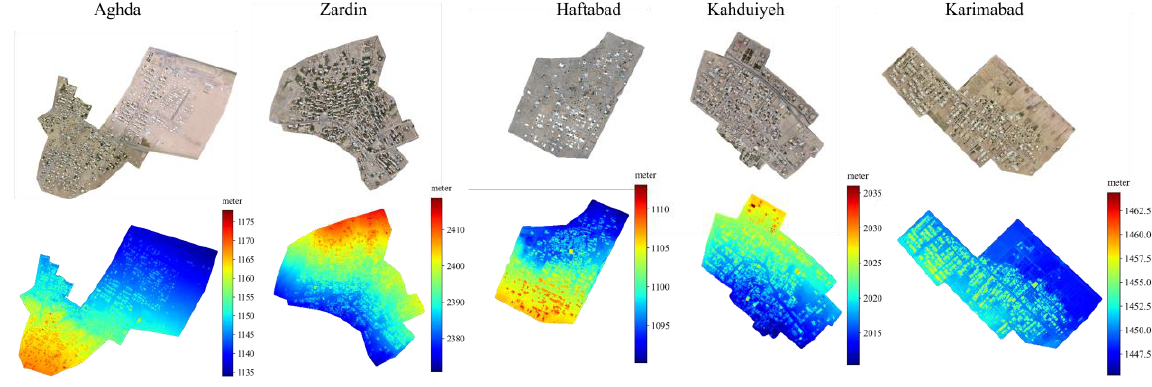
Figure 2 . Overview of training and test